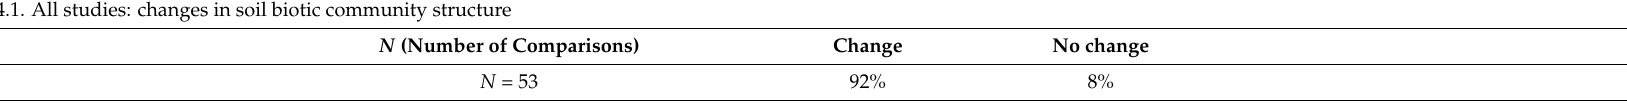
Table 4. AGSOBIO meta-analysis. This analysis drew from 50 published research papers with 53 land-use and crop rotation comparisons of community composition, total biomass of target biota in the study, and soil ecological function under increasing levels of aboveground plant diversity. Sections 4.1 and 4.2 show the change of community structure, and any increase, lack of change, or decrease in soil biological diversity with increases in aboveground diversity. Section 4.3 divides the analysis into studies that assessed increasing diversity via land use change (e.g., forest conversion to crops, secondary succession from crops, and adoption of agroforestry) versus those that assessed increasing diversity in comparisons of crop rotations and associated short-term pasture or fallow management. Section 4.4 groups the studies by soil biota functional type for which there were sufficient research